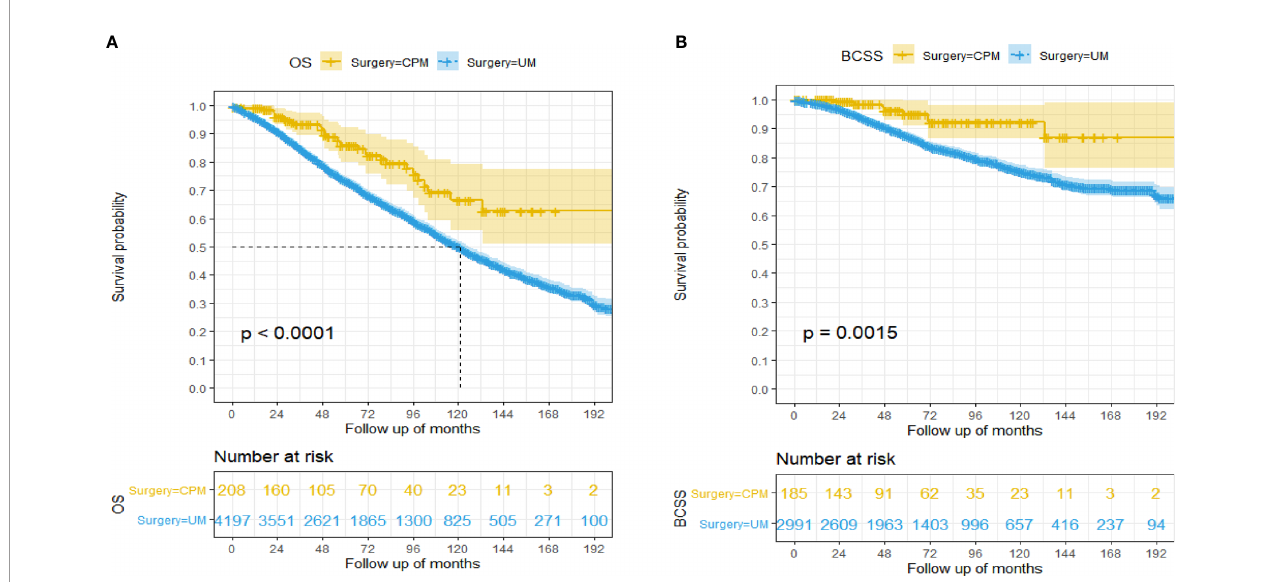
FIGURE 2 | Kaplan-Meier survival analysis for male breast cancer patients. (A) Overall survival curves in the CPM group and UM group. (B) Breast cancer-speci fi c survival curves in the CPM group and UM